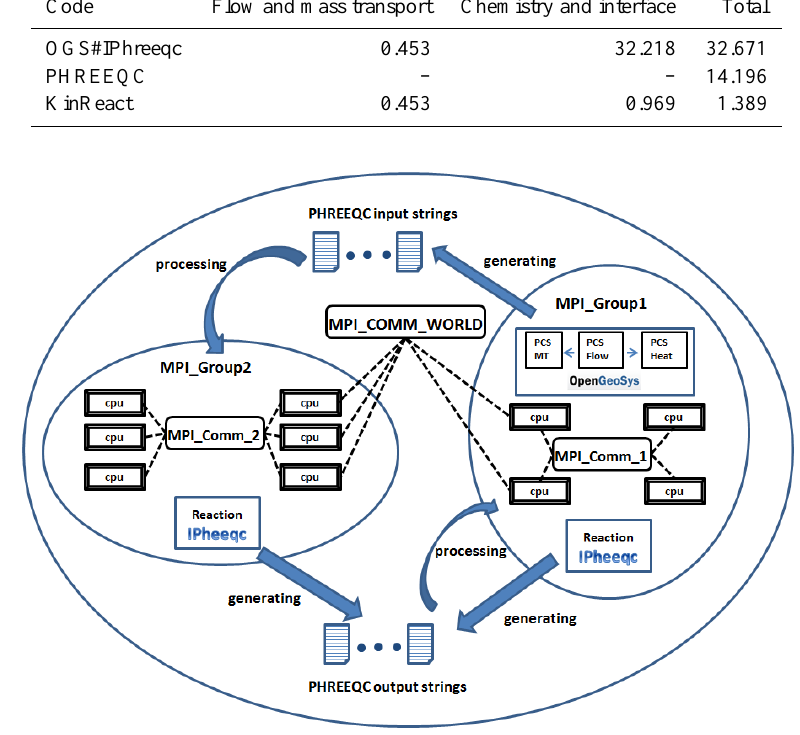
Figure 5. Parallelization scheme for OGS#IPhreeqc. Two distinct MPI groups and relevant inter- and intra-communicators are created. MPI_Group1 takes part in the simulation of both DDC-related processes and chemical reactions, while MPI_Group2 only participates in the simulation of chemical reactions. PCS MT, PCS Flow and PCS Heat are process of mass transport, flow and heat transport,